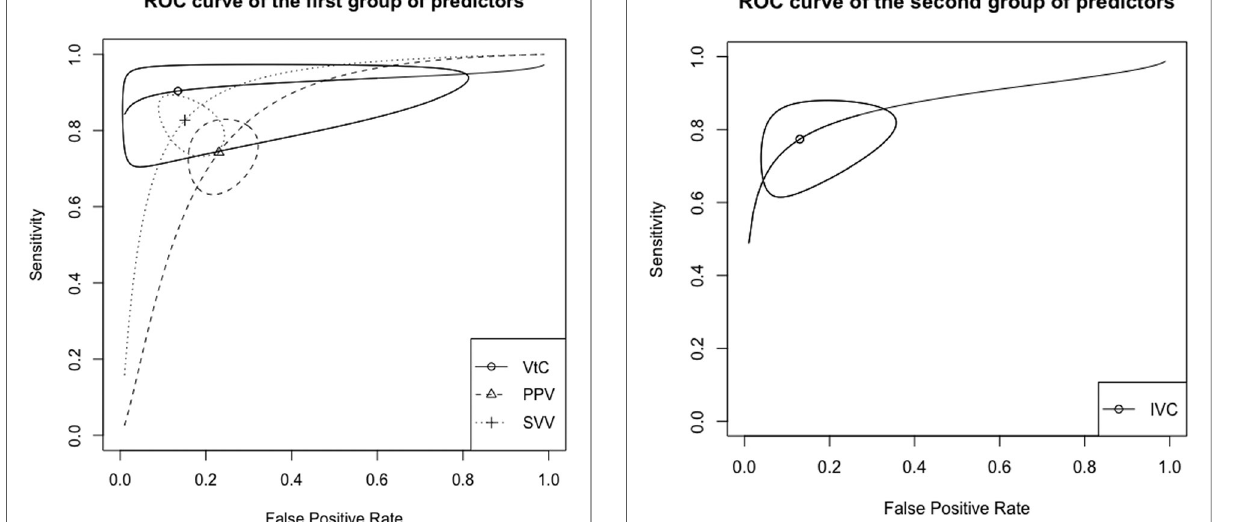
Fig. 2 Summary ROC curve for the first group of predictors of fluid responsiveness. SVV, stroke volume variation; PPV, pulse pressure variation; VtC, tidal volume challenge. Closed curve: 95% confidence region